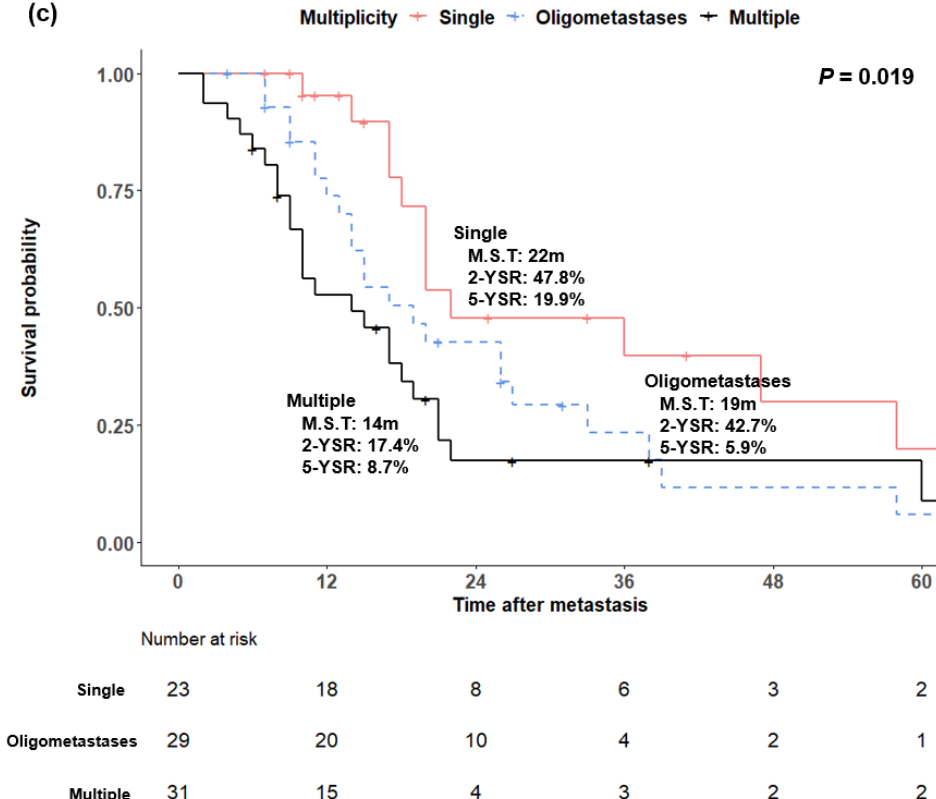
Figure 3. ( a ) Kaplan − Meier analysis of pancreatic ductal adenocarcinoma patients with distant metastasis according to metastatic sites. ( b ) Kaplan − Meier analysis of pancreatic ductal adenocarcinoma patients with isolated lung metastasis according to the temporal metastatic pattern. ( c ) Kaplan − Meier analysis of pancreatic ductal adenocarcinoma patients with isolated lung metastasis according to multiplicity of lung lesions. M.S.T., median survival time; YSR, year survival rate.